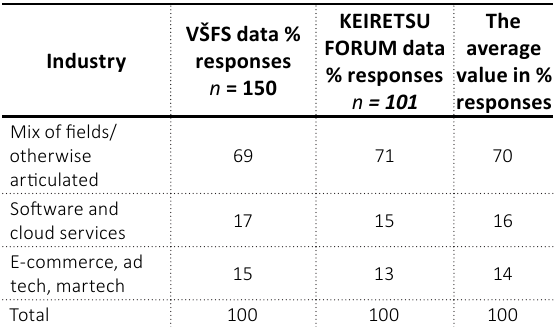
Table 5. Startups by area of business – the factor of attractiveness of their industry or field Source: Own processing.